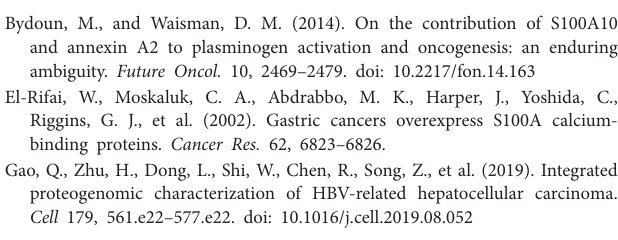
Supplementary Figure 1 | The survival-associated DEGs were identified as potential oncogenes for further validation. Supplementary Figure 2 | The raw data from OEP000321 were normalized using the R package